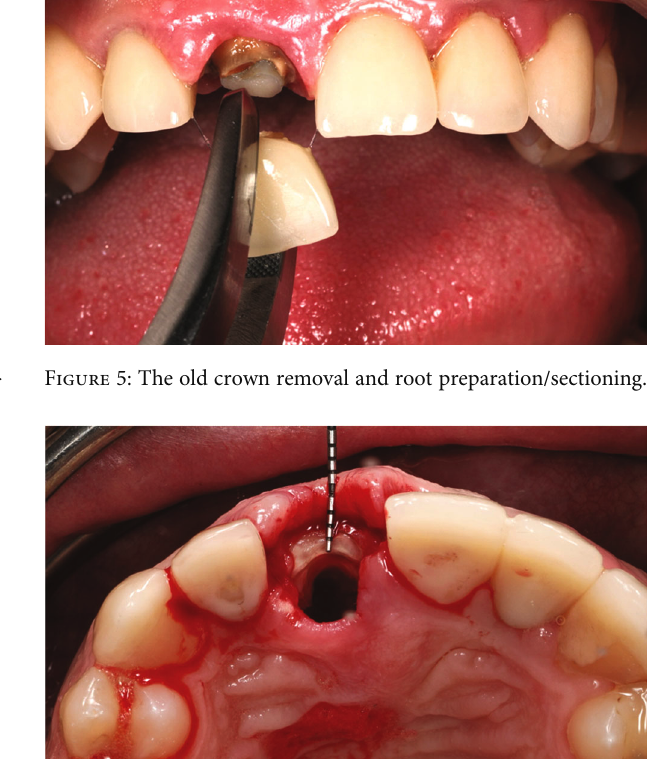
Figure 4: Surgical implant stent digital planning.